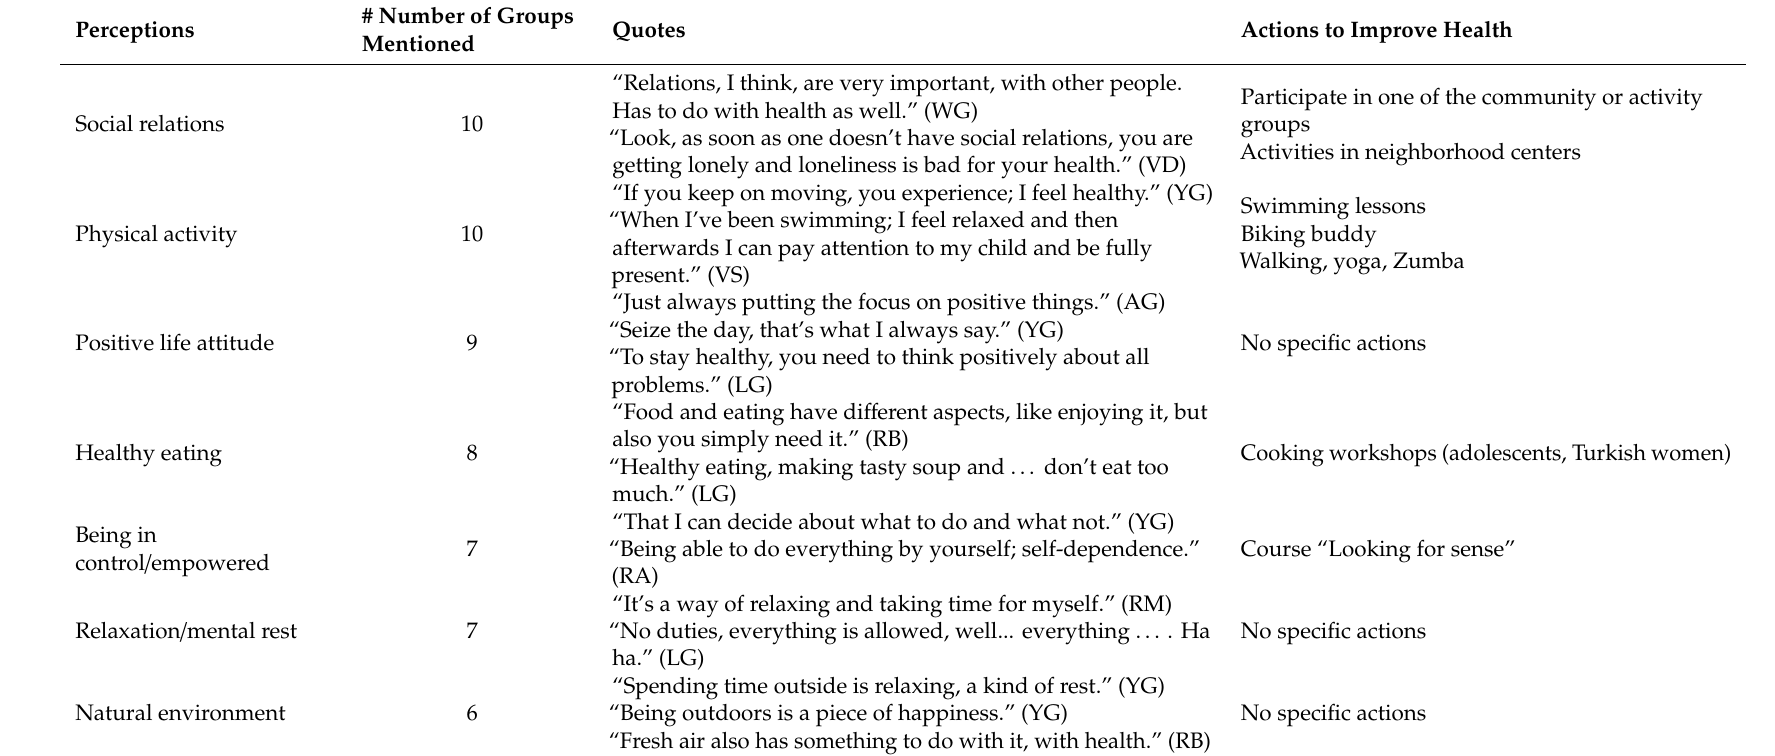
Table 3. Clusters of statements / perceptions of health in order of